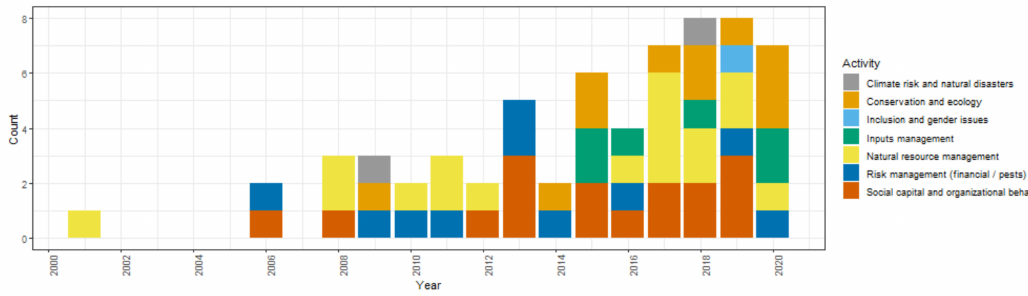
Figure A3. Frequency of studies by activity focus over